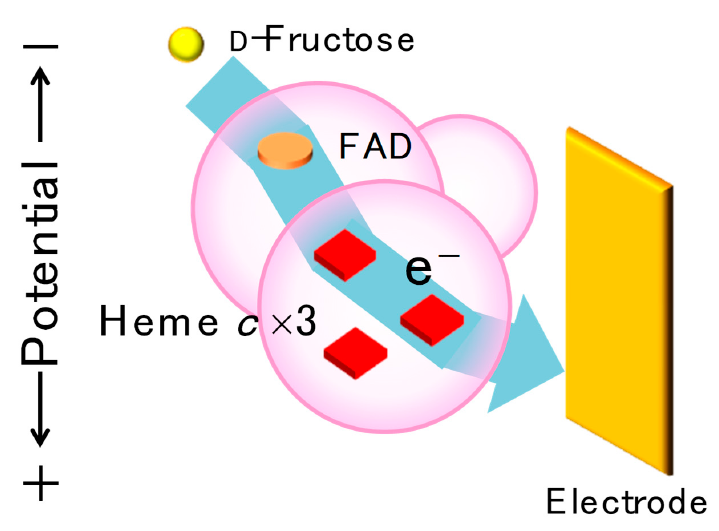
Figure 9. Schematic view of proposed electron transfer pathway from d -fructose to an electrode in a DET-type reaction of d-fructose dehydrogenase (FDH). The electrons are transferred from substrate-reduced FAD to heme 3 c , heme 2 c , and an electrode without going to heme 1 c . Reprinted from [28], Copyright (2019), with permission from Elsevier.